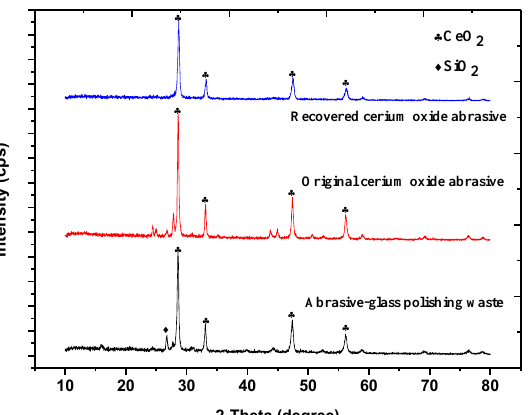
Figure 10. XRD analysis of the recovered cerium oxide abrasive, the original cerium oxide abrasive, and the abrasive–glass polishing waste (experimental conditions of the recovered cerium oxide abrasive: abrasive–glass polishing waste: approximately 1 g; roasting temperature: 450 ◦ C; mass ratio of polishing waste to NaOH: 1:1; roasting time: 30 min; water leaching pH: 3, leaching temperature: 25 ◦ C, liquid–solid ratio of 25 mL / g).